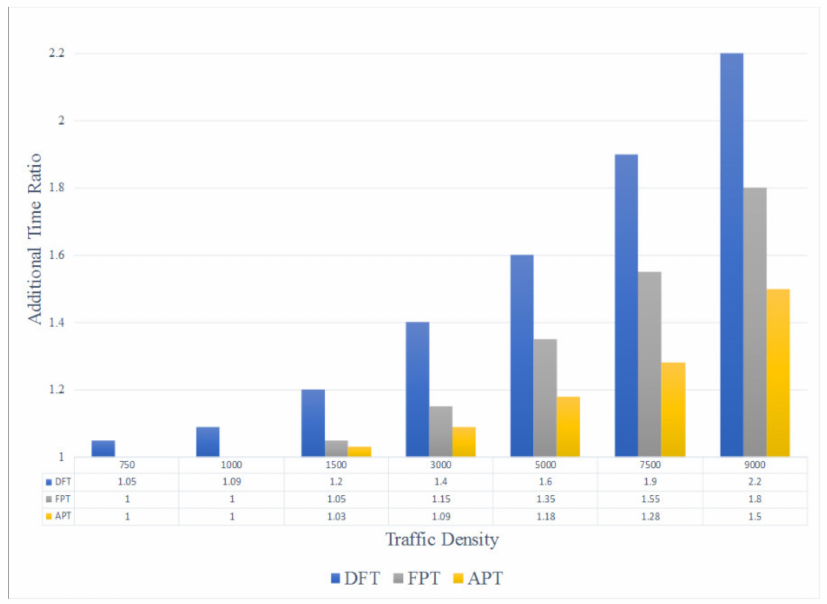
Figure 6. Tra ffi c density vs. additional time.